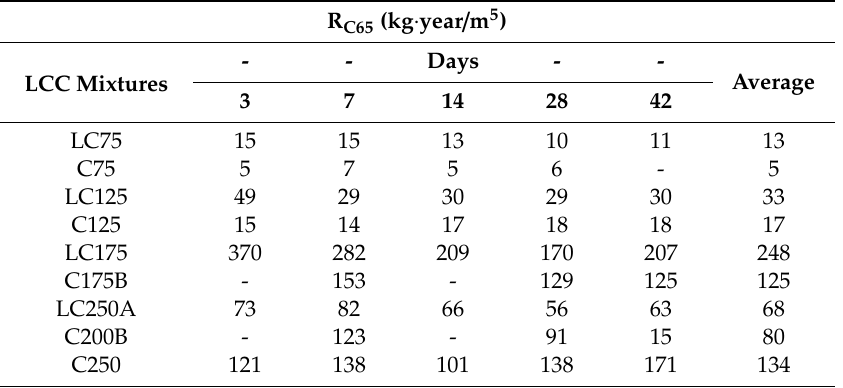
Table 4. The carbonation resistance, R C65